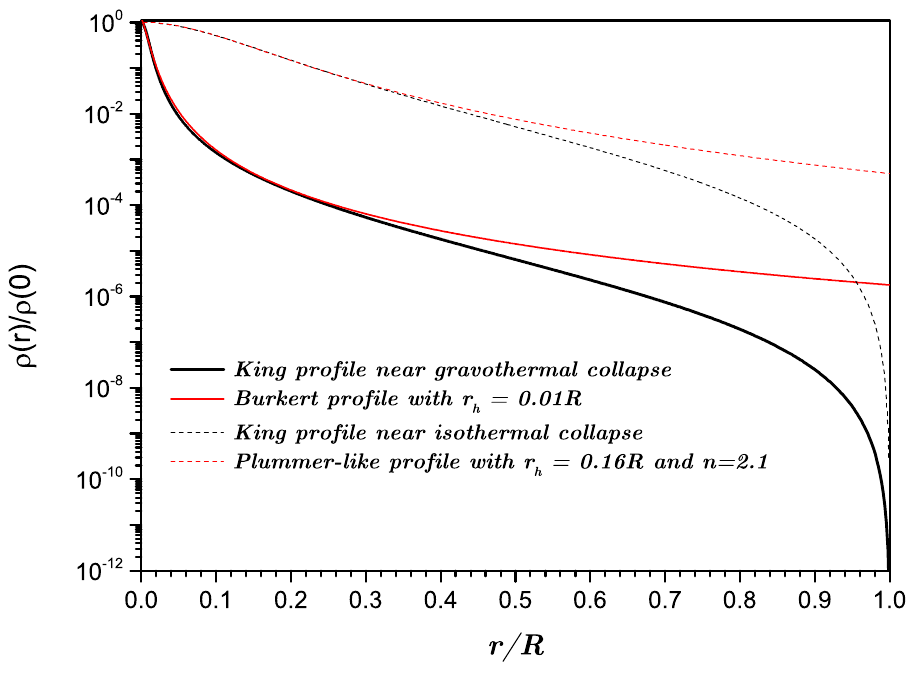
Figure 3. Comparison of two King profiles with and without isothermal cores, and the empirical profiles of Burkert (32) and Plummer-like (33). Here, R denotes the tidal